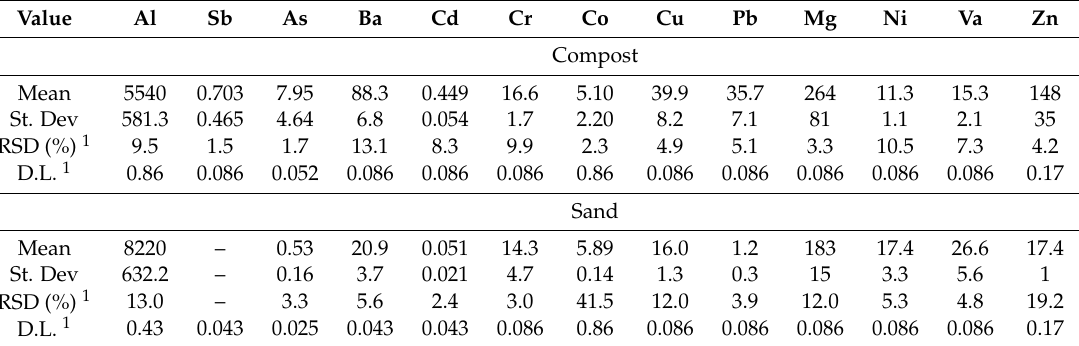
Table 1. Metal concentrations (mg kg − 1 ) of compost and sand used in